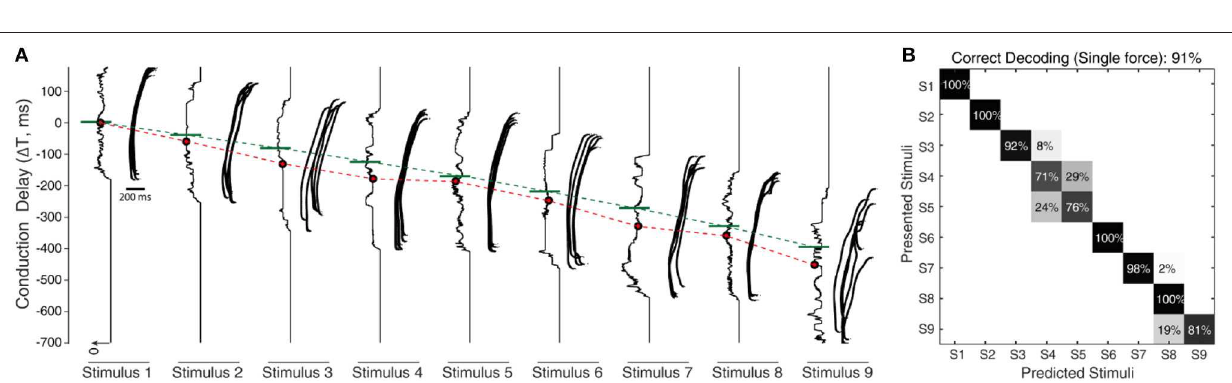
FIGURE 7 | Processing stimuli orientation with noise. (A) Raster plot illustrates the responses of CNs (2nd order neuron) for all 9 stimuli (S1–9), across a range of fixed conduction delays varying between 175 and − 700ms, with a step of 1ms. The responses illustrated are for fixed sensing force and sensing velocity. Each CN model is simulated for 5 experimental repetitions with an addition of 19 noise repetitions each, constituting a total of 100 repetitions for each CN configuration. The noise was generated by a gaussian distribution with σ = 10ms. The continuous plot alongside each raster plot illustrates the density of spiking for that respective differential conduction delay. The green line illustrates the theoretical value (Equation 5) of conduction delay. The median value of the density is indicated in red dot. The red line across stimuli illustrates the linear shift of spiking probability across different conduction delays. (B) Confusion matrix illustrating the decoding performance that is achieved by CNs across all the 9 stimuli (for a single sensing force and sensing velocity), using supervised linear discrimination classifier. The decoding accuracy was 100% across 5 stimuli with a step size of 10 ◦ (S1, S3, S5, S7, and S9), and 91% with a step size of 5 ◦